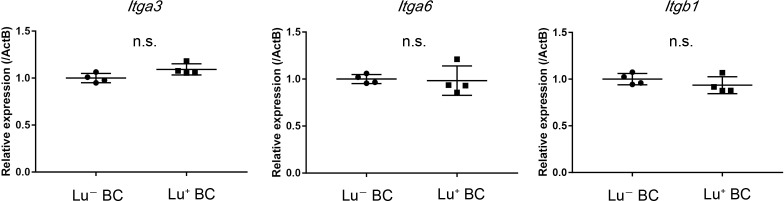
Gene expression analysis of Itga3, Itga6 and Itgb1 mRNA in Lu- and Lu+ BC by quantitative RT-PCR.Relative expression level is plotted in a graph with mean and standard deviation (n = 4). n.s.: not significance.10.7554/eLife.36572.018Figure 5—figure supplement 2—source data 1.Numerical data for expression analysis of Itga3, Itga6 and Itgb1 mRNA in Lu+ BC and Lu- BC by quantitative RT-PCR.